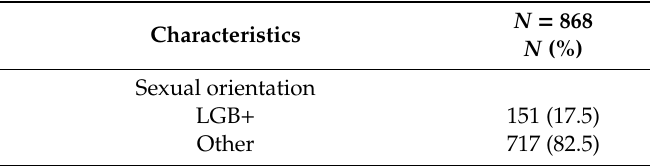
Table 1. Descriptive statistics of the sample.